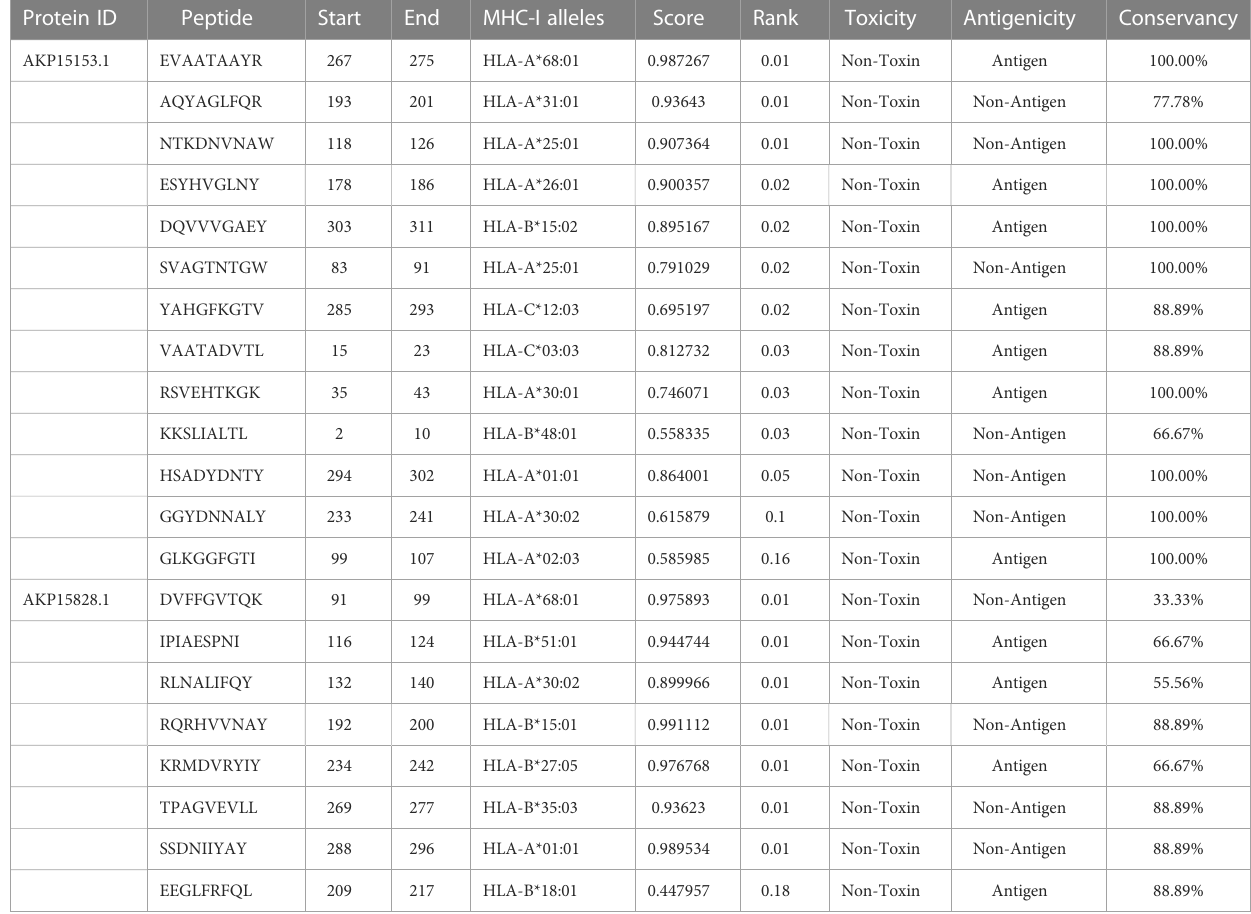
TABLE 3 MHC-I interacting T-cell epitopes for the two potential vaccine candidate proteins. Protein